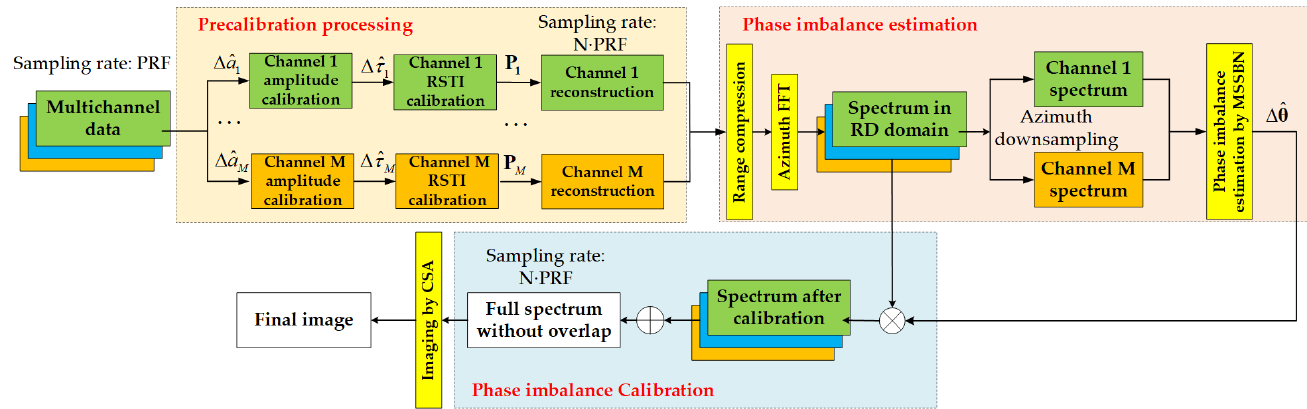
Figure 7. The processing flowchart of the proposed method.